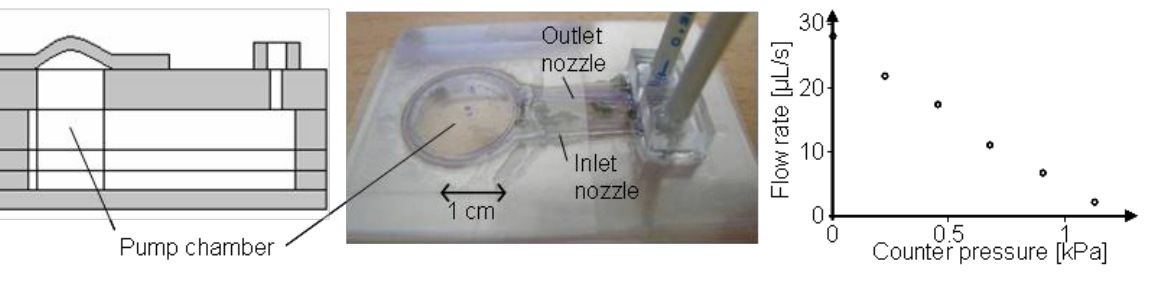
Figure 6. From left to right: Schematic drawing of the micro pump (not to scale), photo, and characteristic curve when driven at 12.5